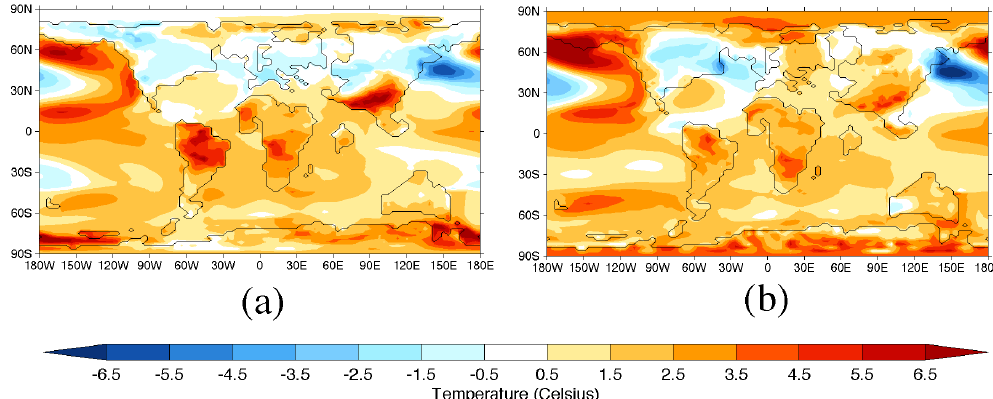
Fig. 13. Daily evapotranspiration difference between (a) 2 × DYN and 2 × SHRUB, (b) 4 × DYN and 4 × SHRUB, (c) 4 × DYN and 4 × FIXED, and (d) 4 × FIXED and 2 × DYN.